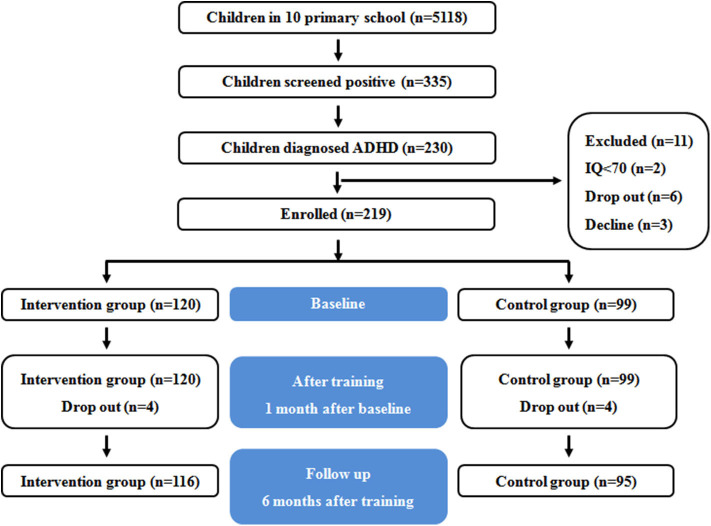
A flow diagram of participants.